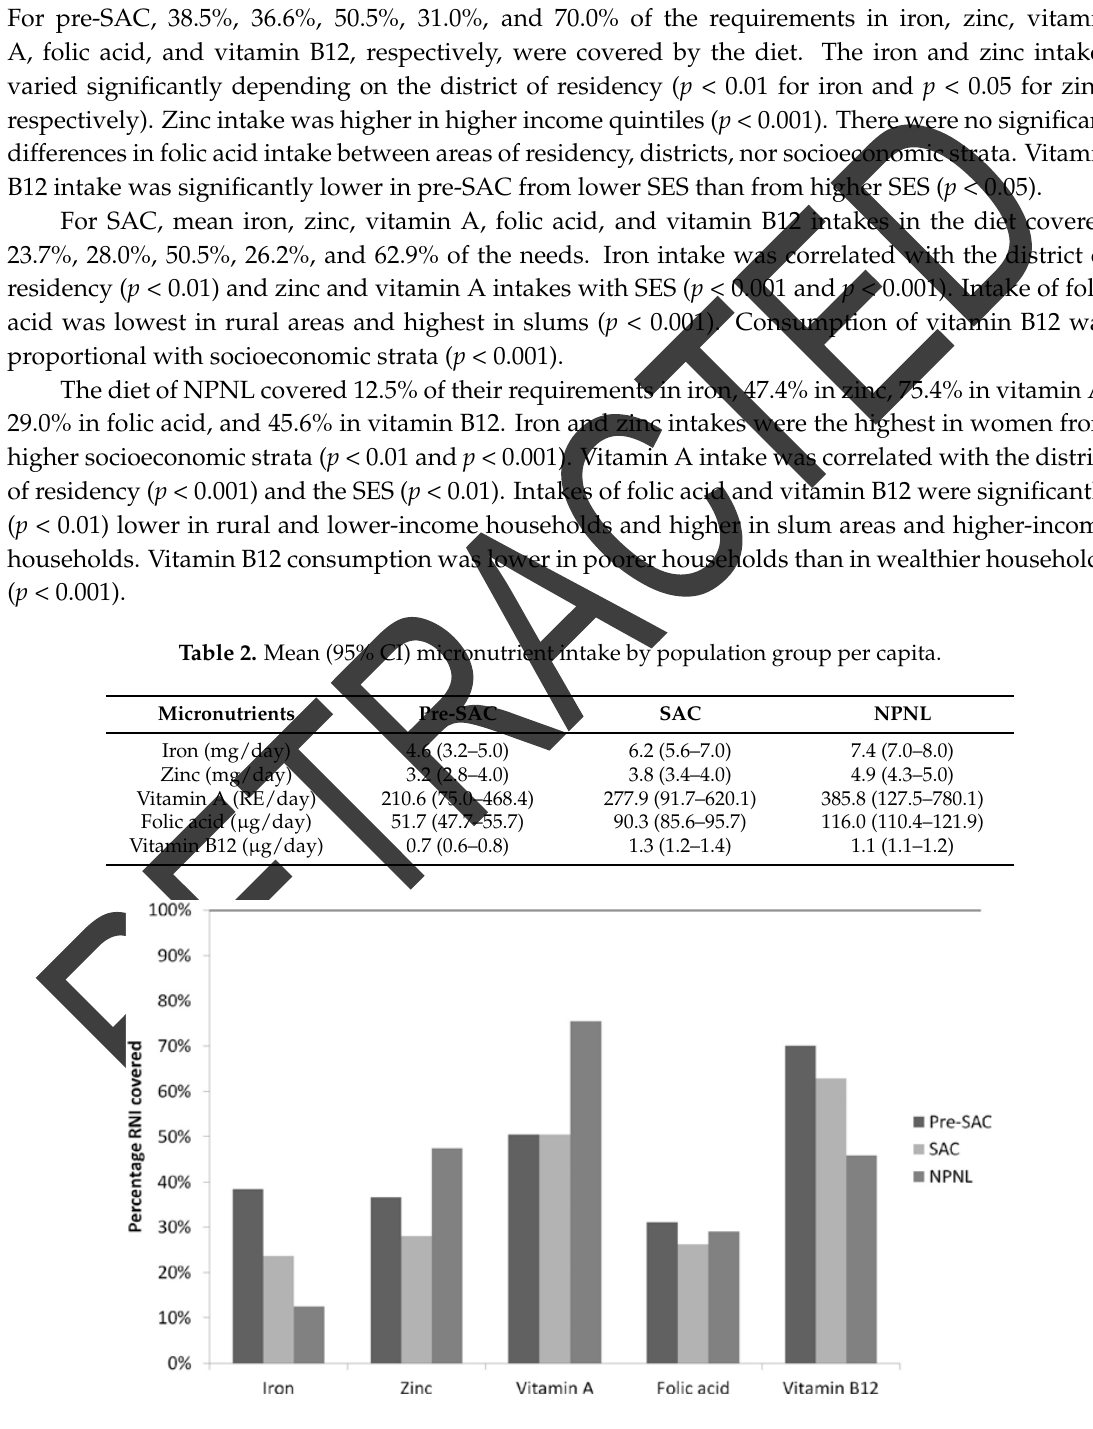
Figure 1. Percentage of iron, zinc, vitamin A, folate, and vitamin B12 RNI covered by the diet per population group.